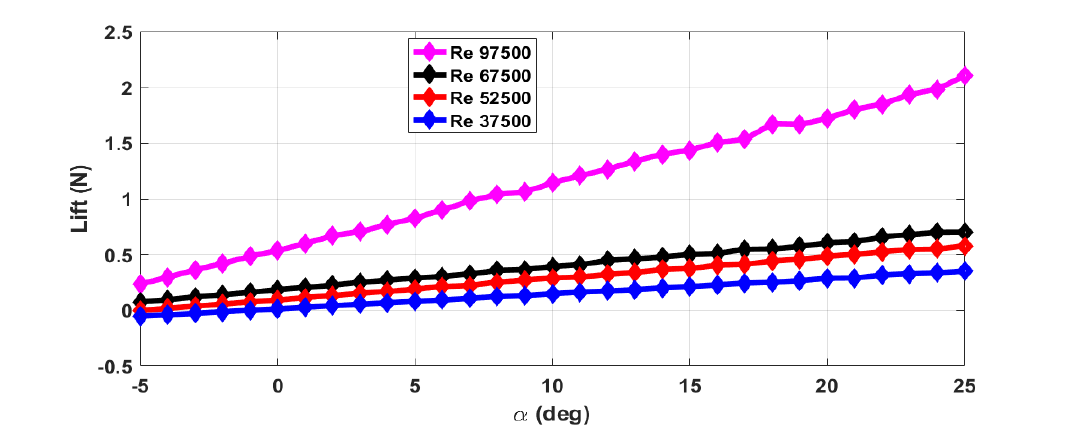
Figure 4. Lift force for zero elevator deflection and zero propeller RPM.